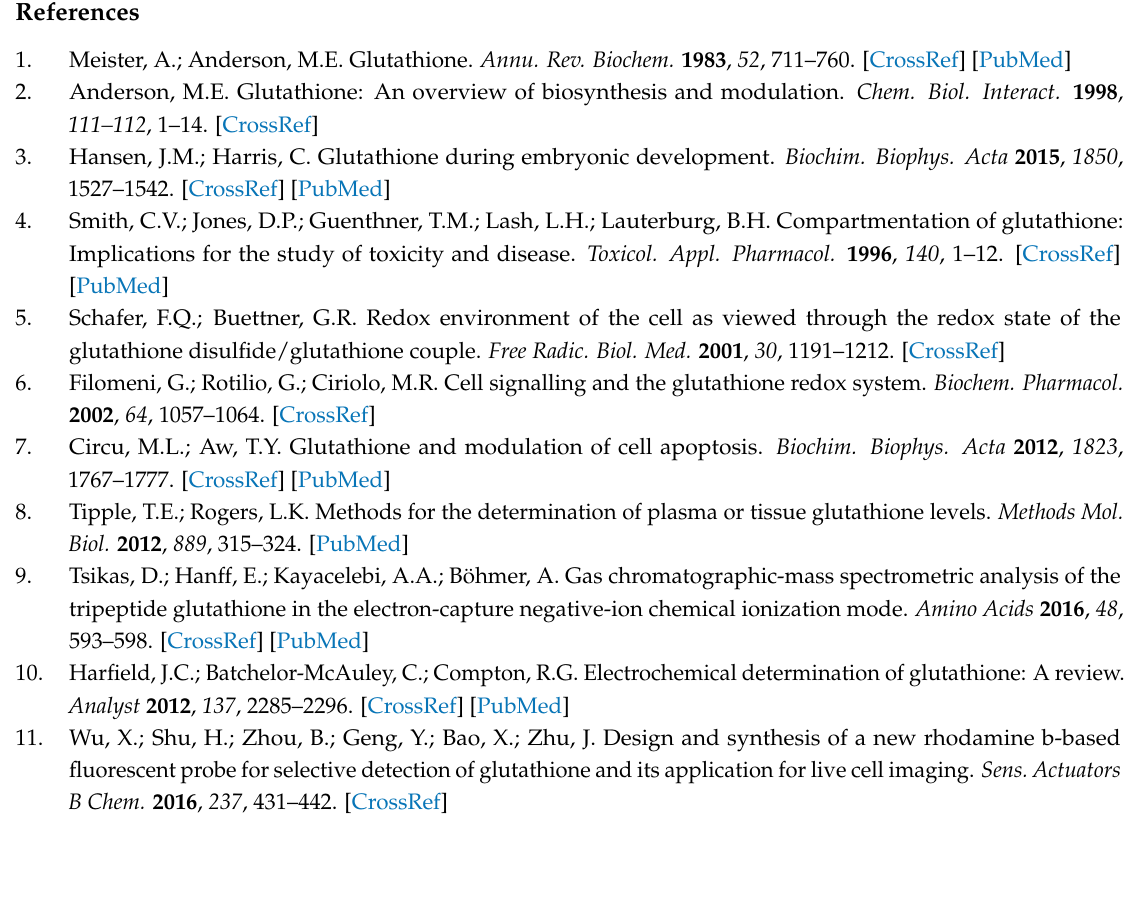
Figure S2: Fluorescence of Sensor 1 and 6 , Figure S3: Quantum yield of sensor 1 , Figure S4: Cytotoxicity of Sensor 1